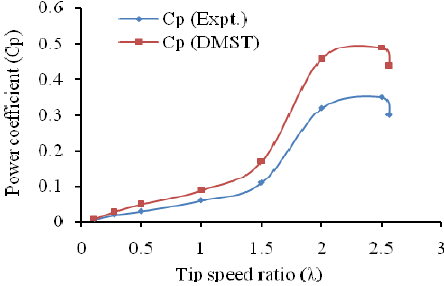
Figure 16. Cp versus λ at V ∞ = 8 m/s